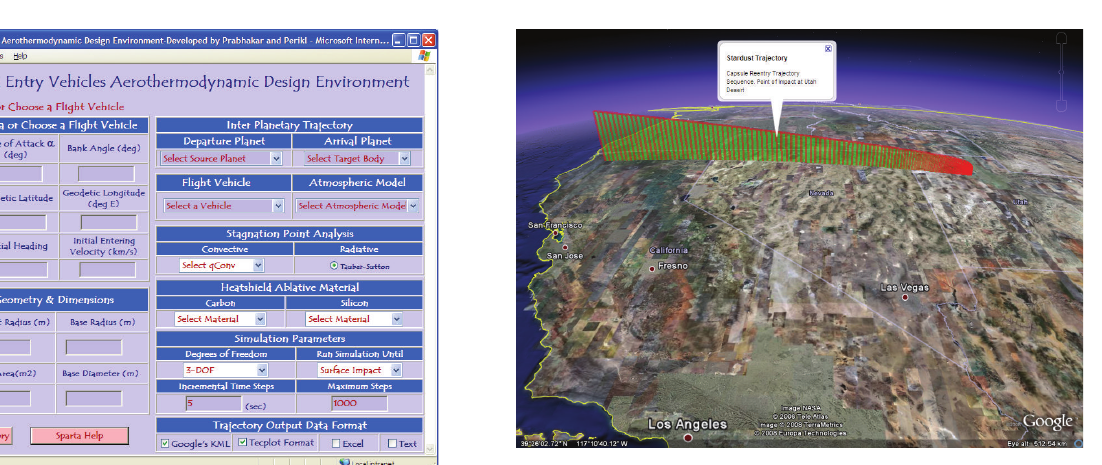
Figure 13: Google Earth: Stardust entry trajectory